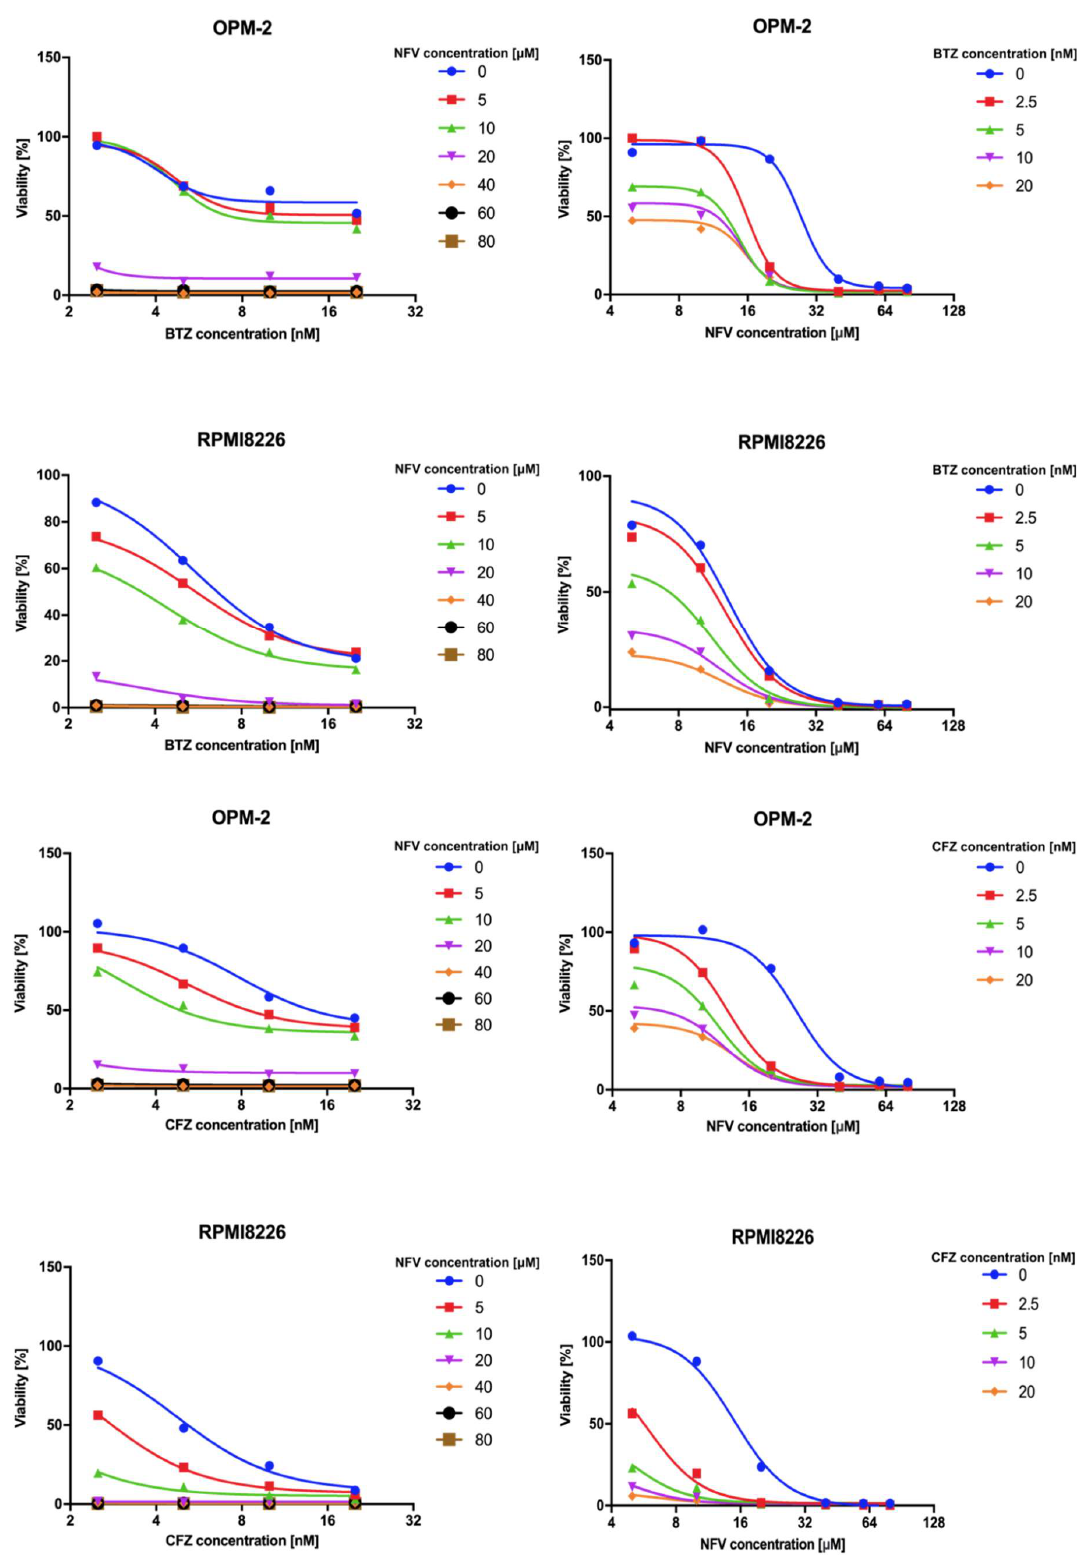
Figure 6. Cytotoxic activity of nelfinavir on OPM-2 and RPMI8226 cell lines. Both cell lines were incubated with increasing concentrations of BTZ or CFZ and nelfinavir as indicated, and cell viability was measured after 24 h with a CellTiter-Glo (Promega) viability assay. Data are shown as the median ( n = 4).